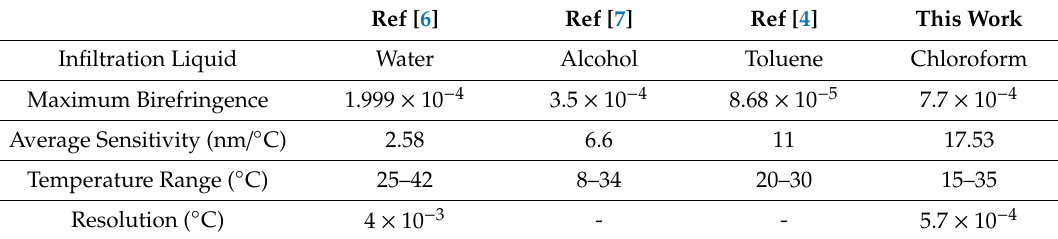
Table 1. The temperature sensing performance of a water-filled PCF in [6], alcohol-filled PCF in [7], toluene-filled PCF in [4], and the proposed chloroform-filled PCF in a Sagnac interferometer.